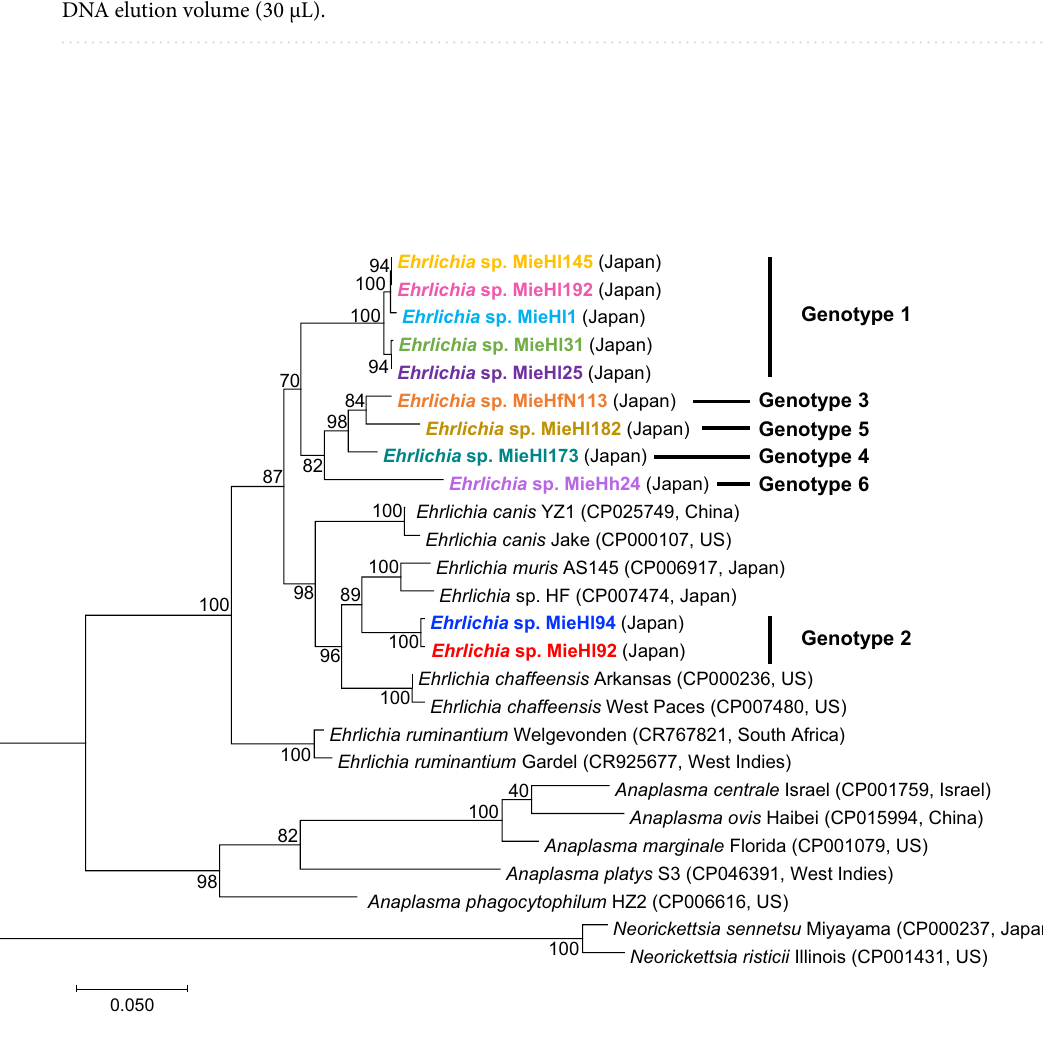
Figure 4. Core-partial-RGGFR-based phylogenetic analysis of uncultured Ehrlichia bacteria and cultured Ehrlichia species with genome sequence data. Tree based on five housekeeping genes ( 16S rRNA - groEL - gltA - ftsZ - rpoB ) of uncultured Ehrlichia bacteria in this study and cultured Ehrlichia species for which complete genome sequence data have previously been obtained were constructed using the maximum likelihood method with the Kimura two-parameter model and “complete deletion” for gap/missing data treatment. The bootstrap values from 1000 replications are shown on the branch nodes. The scale bar indicates the evolutionary distance. The uncultured Ehrlichia bacteria in this study are shown by the colored characters, and their “genotypes” that were estimated based on the core-partial-RGGFR alignment and summarized in Table 4 are shown on the right side. The accession numbers and the location of isolated or identified Ehrlichia species or genotypes are shown in